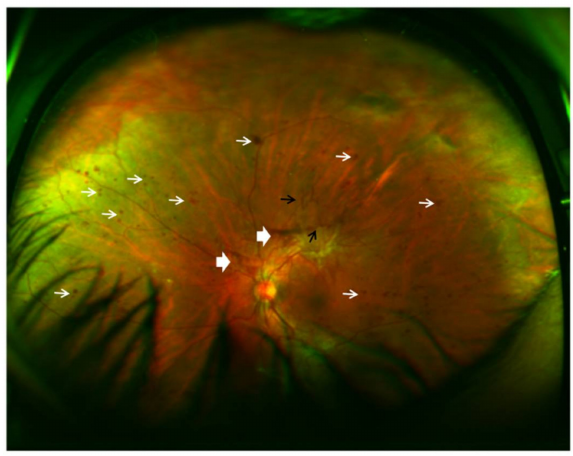
Figure 4. Ultra-wide field fundus SLO image (Optos, Dunfermline, UK) of a patient’s left eye with high risk proliferative diabetic retinopathy. White narrow arrow: severe intraretinal hemorrhages in 4 quadrants, and microaneurysms; white broad arrow: preretinal and vitreous hemorrhage; black arrow: retinal